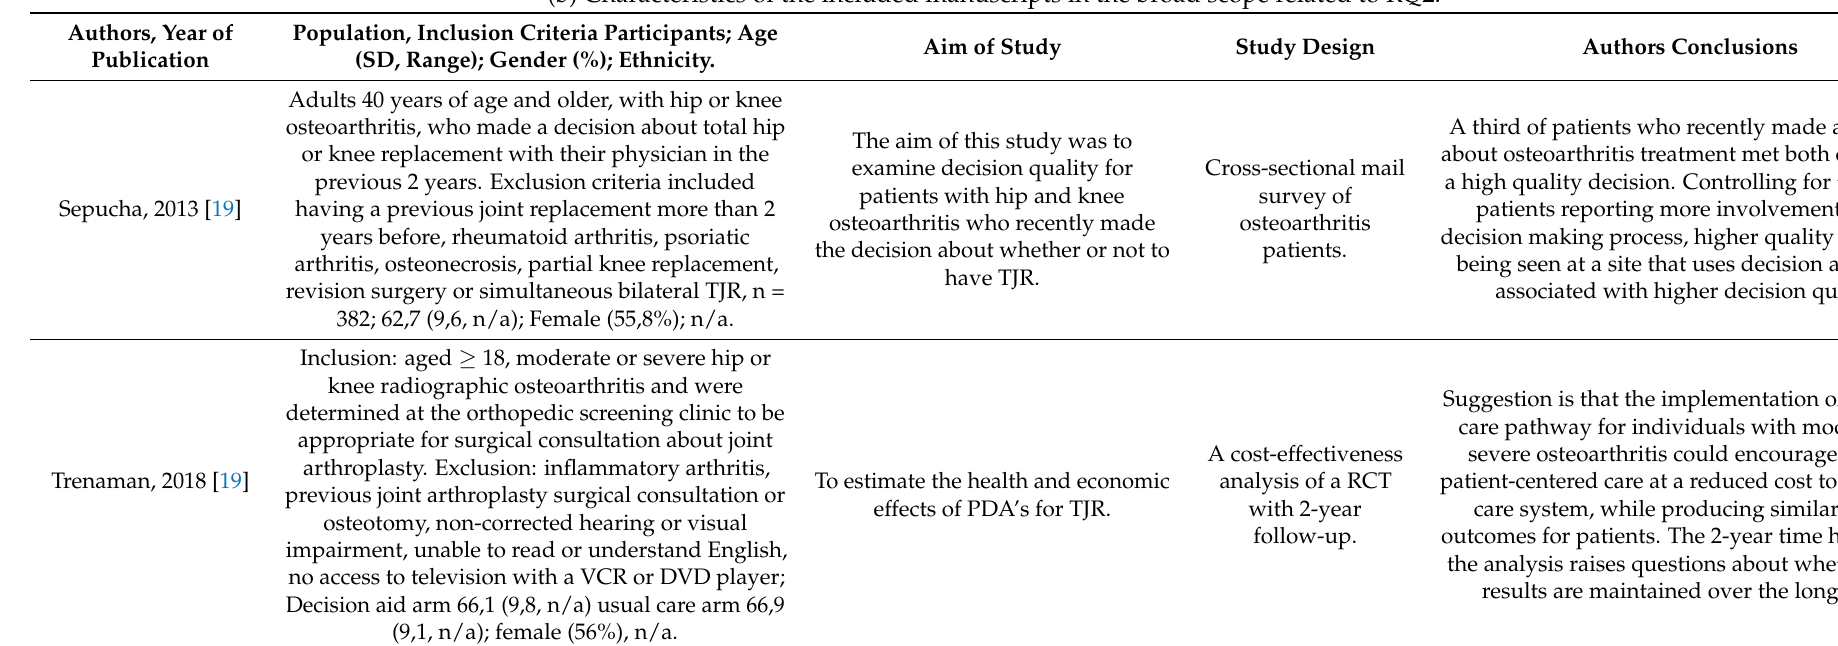
(b) Characteristics of the included manuscripts in the broad scope related to